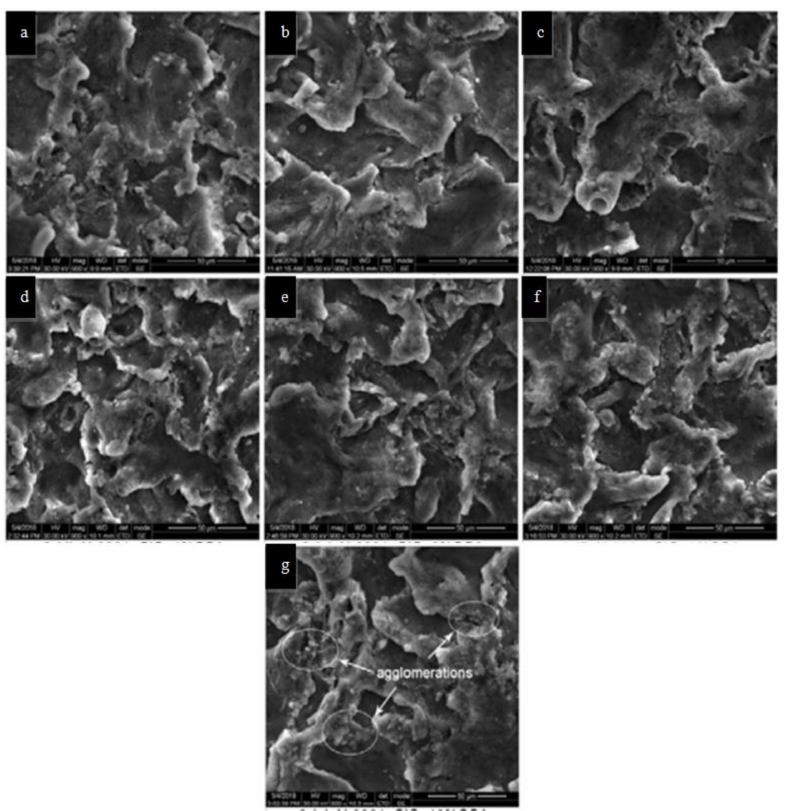
Figure 9. SEM micrographs of Al6061 and its composites ( a ) Al6061 ( b ) Al6061+SiC ( c ) Al6061+SiC+2% CSA ( d ) Al6061+SiC+4% CSA ( e ) Al6061+SiC+6% CSA ( f ) Al6061 +SiC+8% CSA ( g ) Al6061+SiC+10% CSA [126].